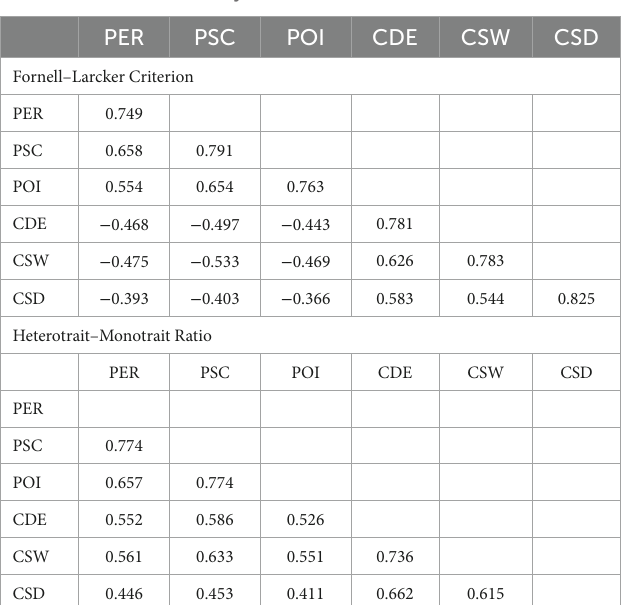
TABLE 4 Mediation effect